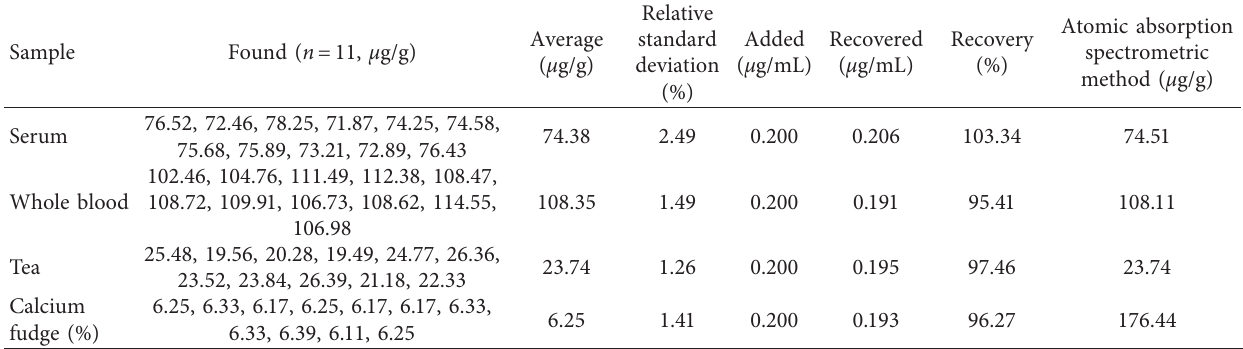
Figure 1: Absorption spectra. (a) Reagent blank (against water); (b) complex (against reagent blank); (Ca 2+ ) � 1.0 × 10 − 5 mol/L, (dibromo- p - Table 1: Analytical results of